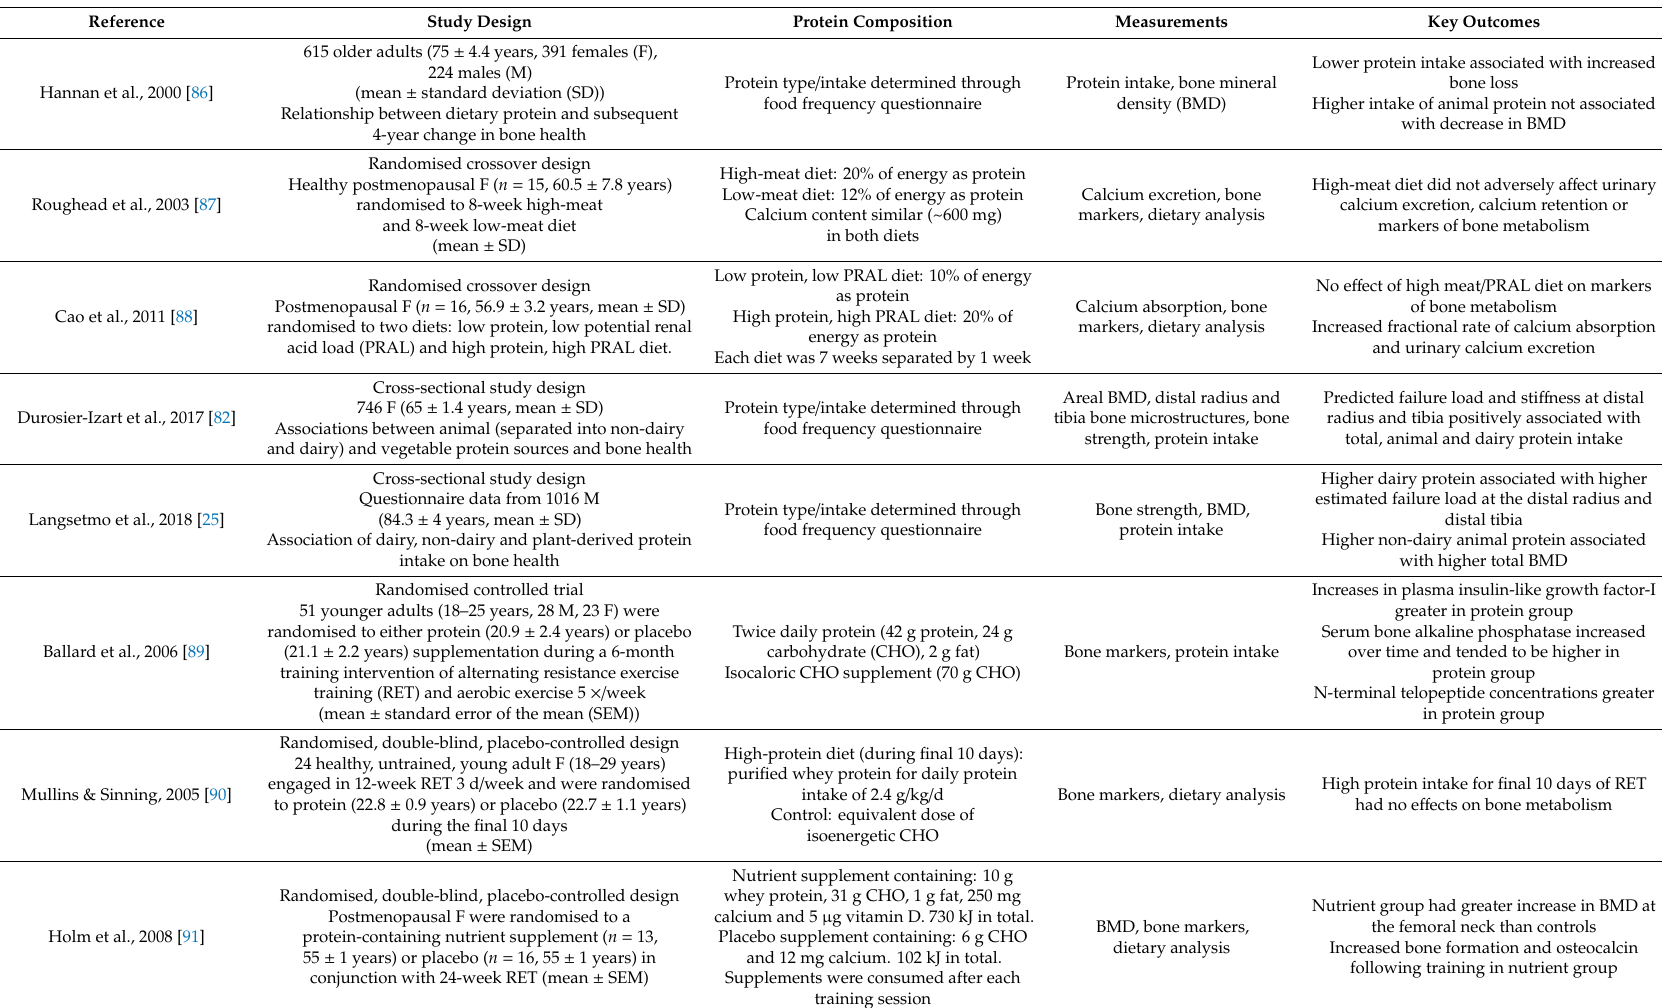
Table 2. Animal-derived proteins: e ff ects on bone in relation to age, exercise, energy restriction and